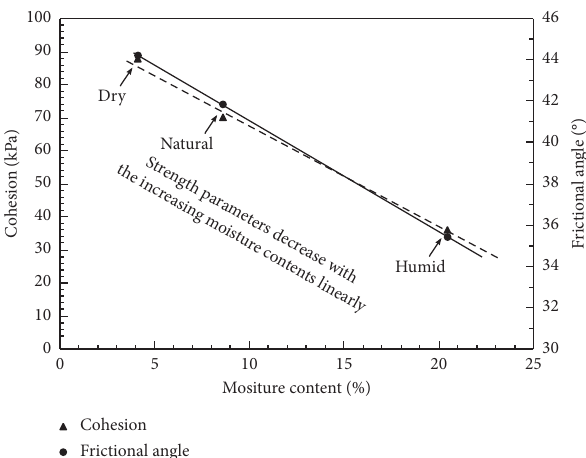
Figure 9: Strength parameters obtained from in situ test versus moisture content.